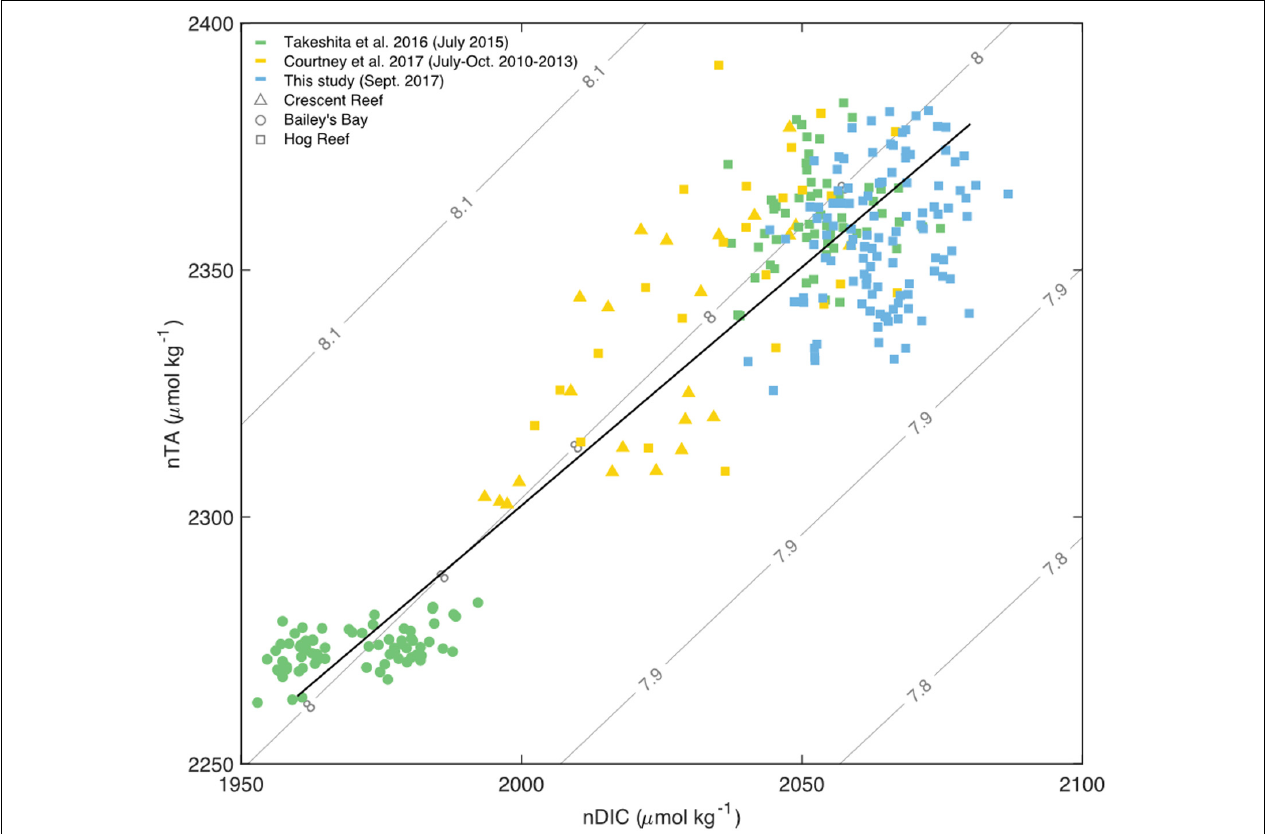
FIGURE 8 | Salinity normalized (36.7 PSU) TA and DIC for water sample data from sites across the Bermuda carbonate platform: Crescent Reef (triangles), Bailey’s Bay (circles), and various expeditions to Hog Reef (squares) ranging from 2010 to 2017 with a Type II linear regression for all data (black) and pH contours. Only data from July to October of each year were used from Courtney et al. (2017; yellow). All data from Takeshita et al. (2016; green) were collected in July 2015. All bottle sample data from the present study were collected in September 2017